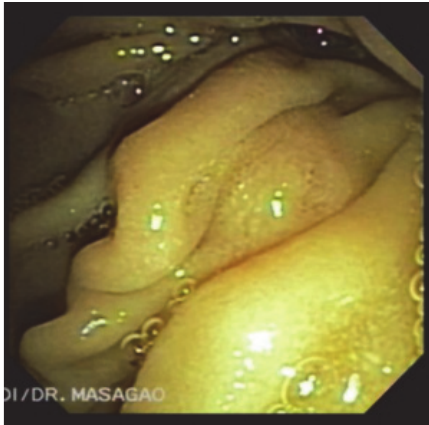
Figure 2: Duodenoscopy shows topic major papilla on the edge of a diverticulum filled with food bezoar (right upper quadrant).